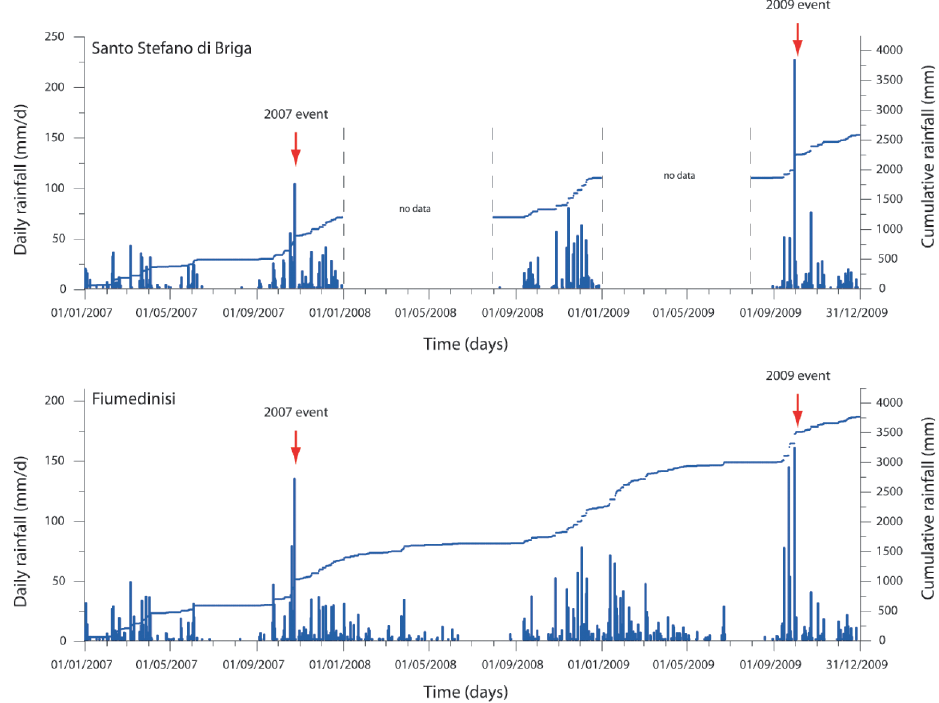
Fig. 2. Daily and cumulative precipitation data for the period January 2007 – December 2009.